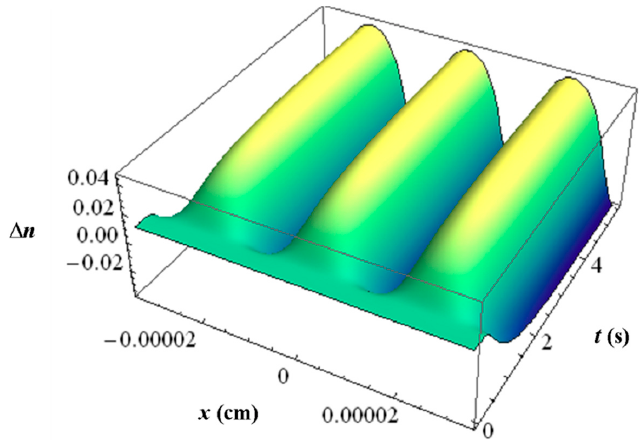
Figure 11. Simulated refractive index profile ∆ n versus time t and space coordinate x for Bayfol ® HX film, calculated for λ = 633 nm, SF = 4525 1/mm, I 0 = 9.12 mW/cm 2 and t exp = 3 s [51].